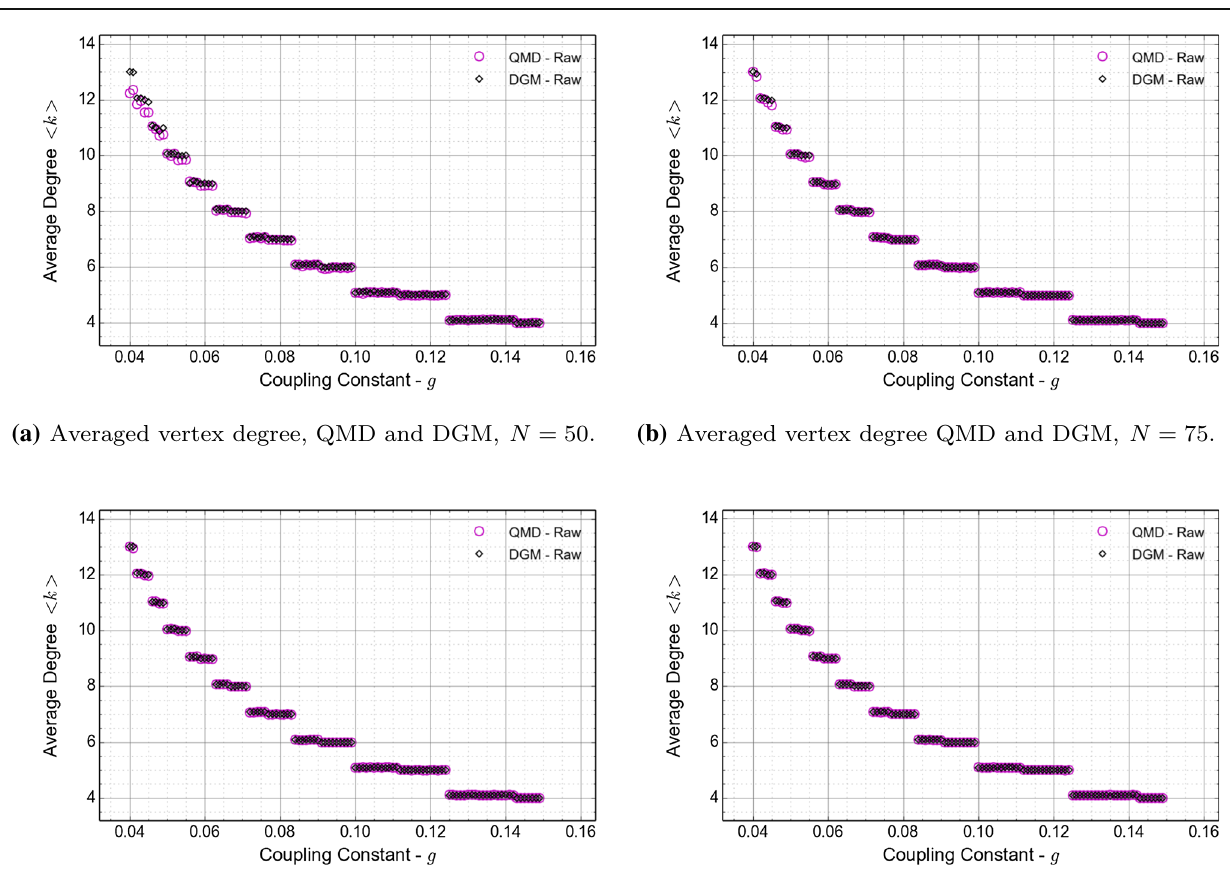
(c) Averaged vertex degree, QMD and DGM, N = 100. ( d ) Averaged vertex degree, QMD and DGM, N = 150. Fig. 4 Comparison of both QMD and DGM vertex degree across a range of graph sizes, with the valued averaged across 10 graph samples. Against each of the data points the error bars represent the 1st standard deviation from the mean value. Both models produce essentially identical values of (cid:11) k